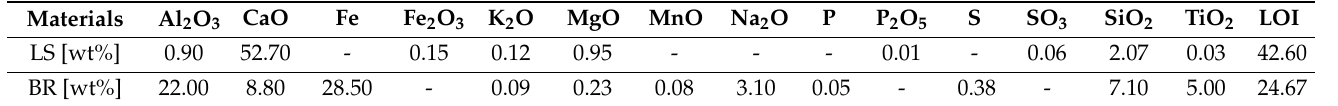
Table 1. XRF analysis of raw materials; limestone (LS) and bauxite residue (BR) .